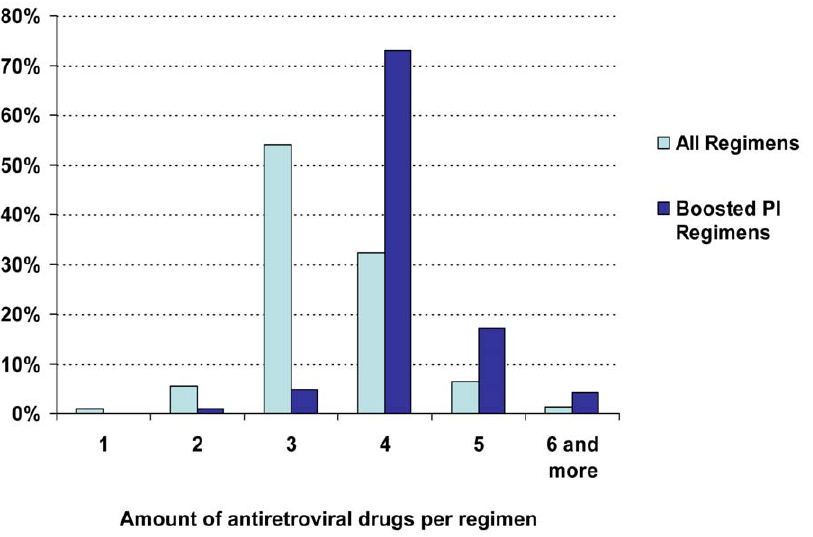
Figure 2. Distribution of the amount of different antiretrovirals per regimen in % of all treatment days. Observation period 1996–2008.